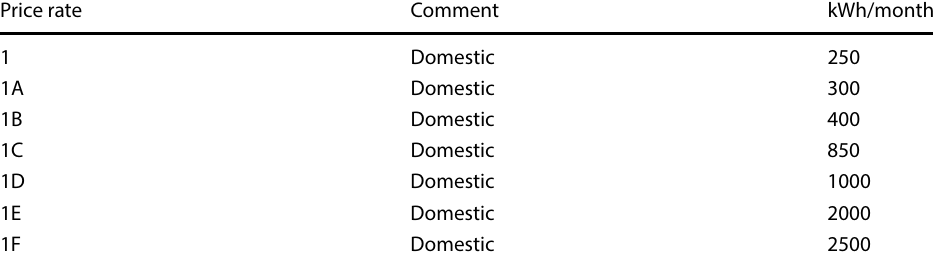
Table 4 Electricity rate Price rate categories for domestic use